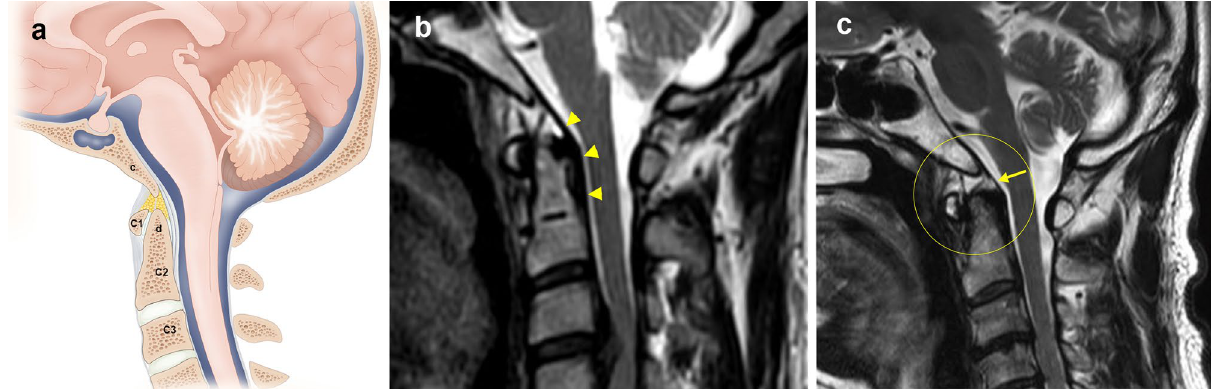
Figure 1. Sagittal view of the craniovertebral junction. ( a ) The cruciate ligament–tectorial membrane (TM)– dura mater complex between the clivus and the body of the axis. c clivus, d dens. ( b ) Sagittal T2-weighted magnetic resonance image shows thin normal delineated TM with normal integrity from clivus to dens (arrowheads). ( c ) Sagittal T2-weighted magnetic resonance image shows a discontinuous TM (asterisks) surrounded by fluid signal intensity. In a patient with TM tear, the TM shows attachment to the superior clivus. The TM tear is visualized at the level of apex of the dens (arrow). At the level of the body of the axis, the TM shows irregular fraying, and the continued posterior longitudinal ligament is retracted with coarse attachment to the dens.